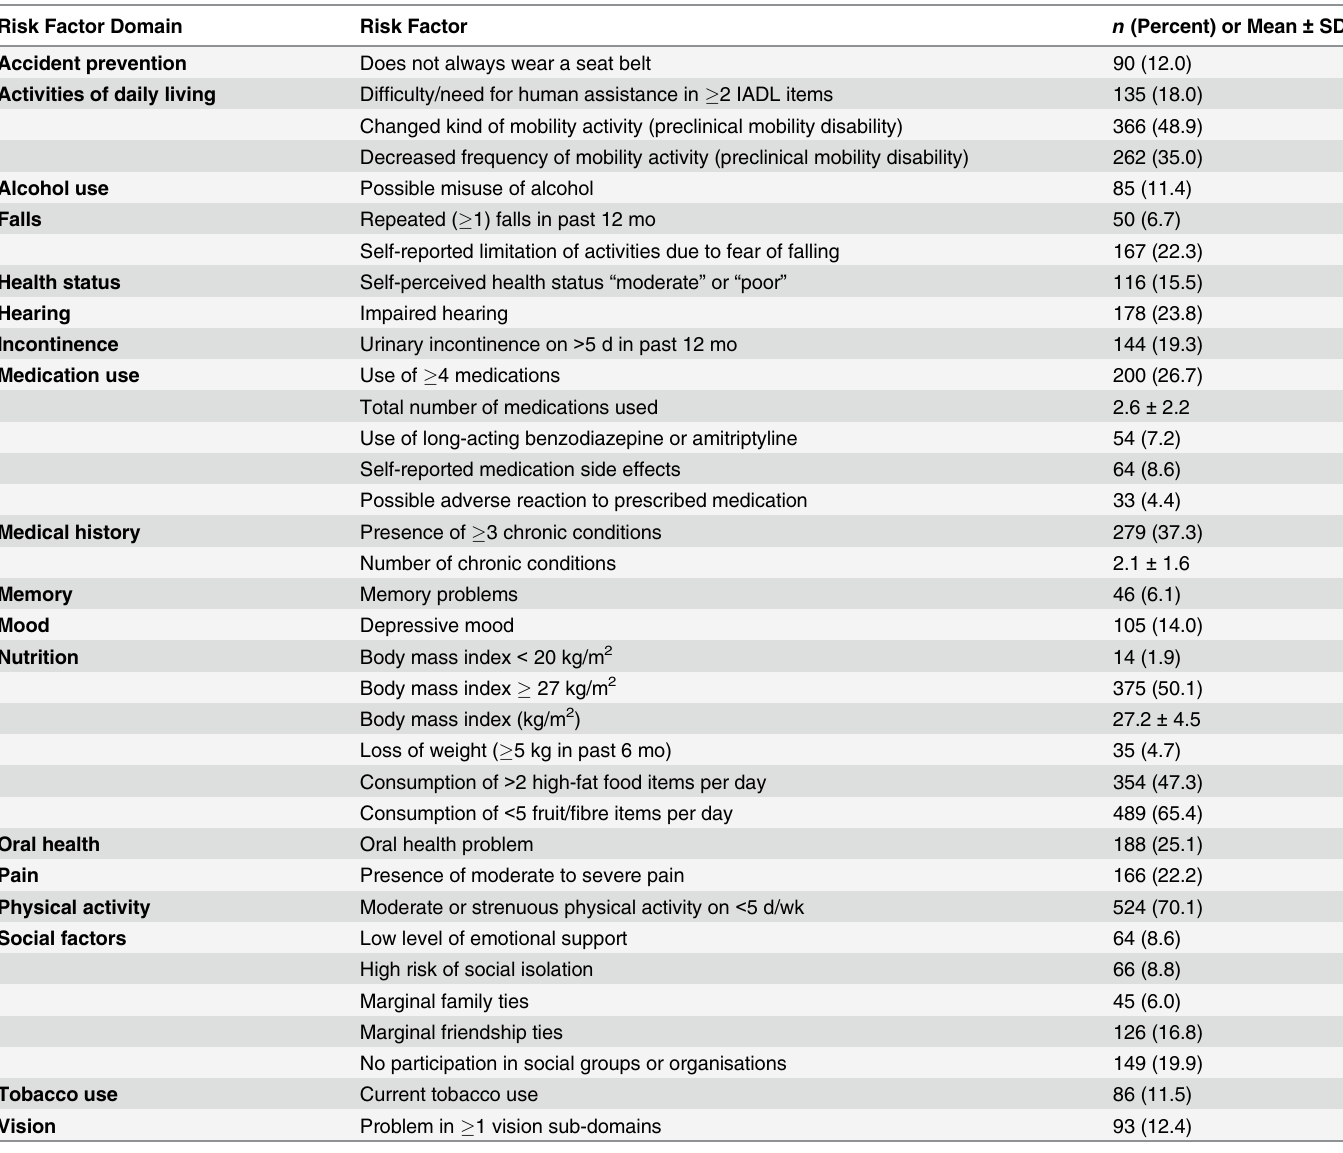
Table 3. Prevalence rates of risk factors for functional status decline among study participants in the intervention group at baseline ( n =